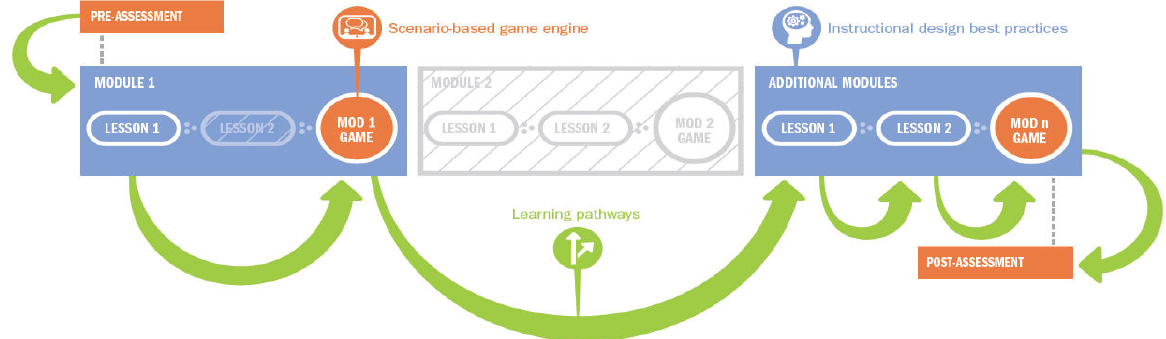
Figure 2. Integration of Design Elements for Accelerated